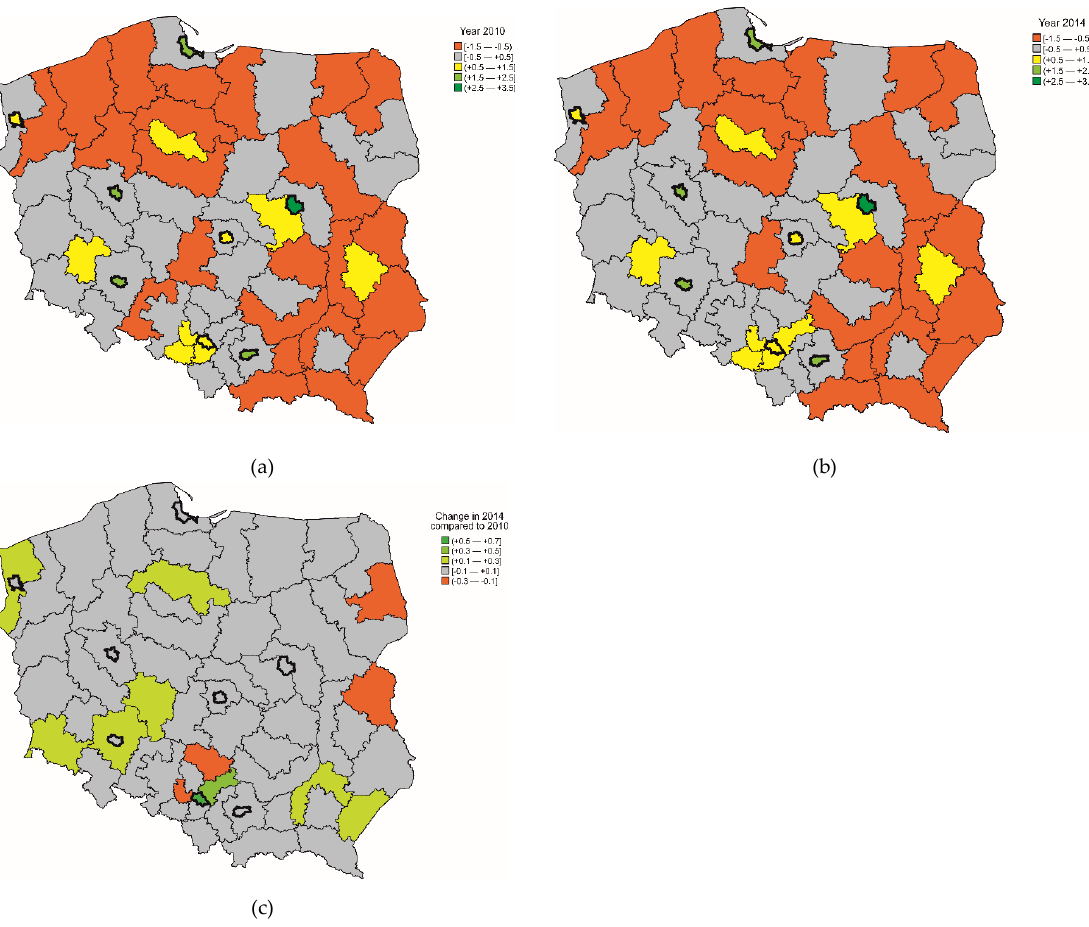
Figure 1. The socioeconomic status (SES) index in ( a ) 2010 and ( b ) 2014 and ( c ) its